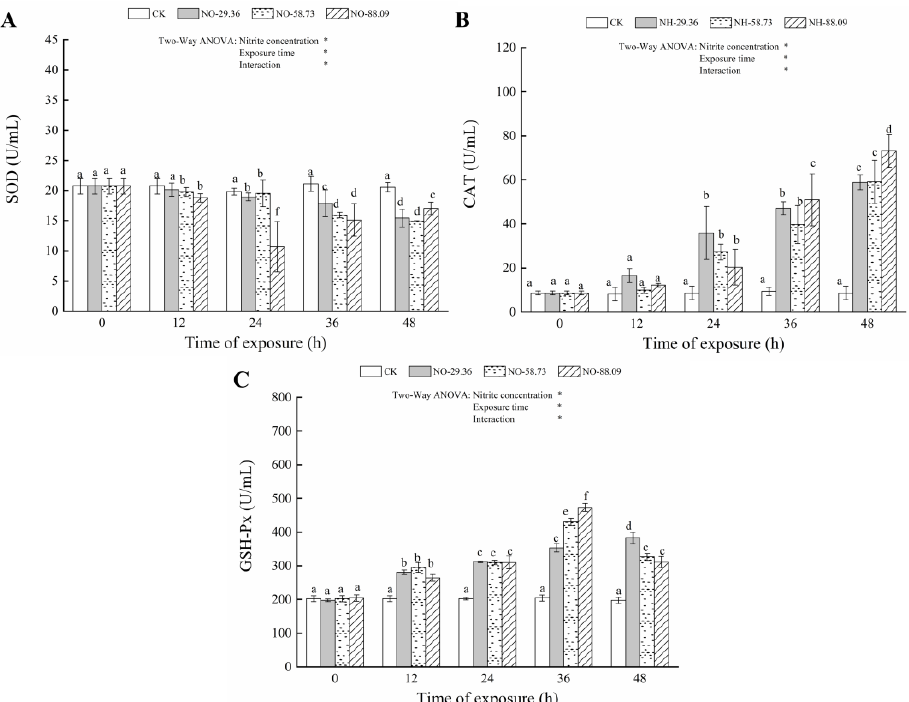
Figure 4. Changes in superoxide dismutase (SOD) ( A ), catalase (CAT) ( B ), and glutathione peroxidase (GSH-Px) ( C ) levels in the serum of large yellow croaker exposed to nitrite at 29.36 mg/L (NO-29.36), 58.73 mg/L (NO-58.73), 88.09 mg/L (NO-88.09), and 0 mg/L (CK) for 48 h. Values are expressed as the mean ± SD. Different lowercase letters indicate significant differences ( p < 0.05) among groups. The CK nitrite group served as the control. * p < 0.05.